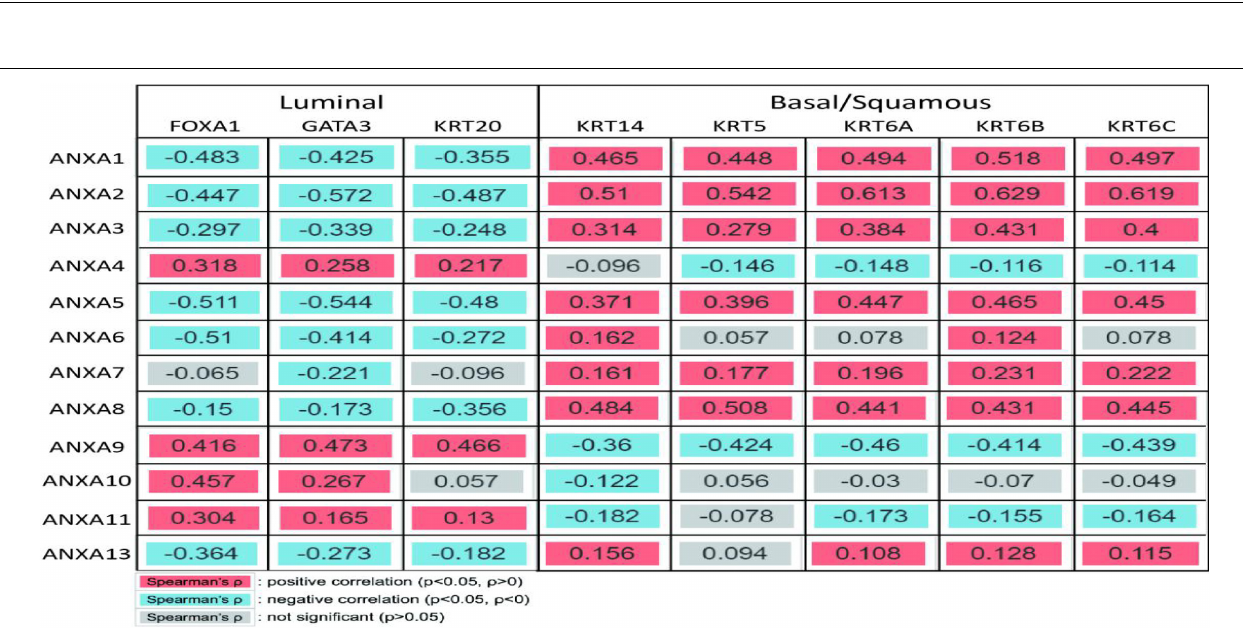
FIGURE 7 | Correlation between ANXA and subtype gene expression. ANXA1, ANXA2, ANXA3, ANXA5, ANXA6, ANXA8, and ANXA13 were significantly positively correlated with the expression of basal type-specific genes and negatively correlated with the expression of luminal type-specific genes. The expression of ANXA4, ANXA9, ANXA10, and ANXA11 showed the opposite